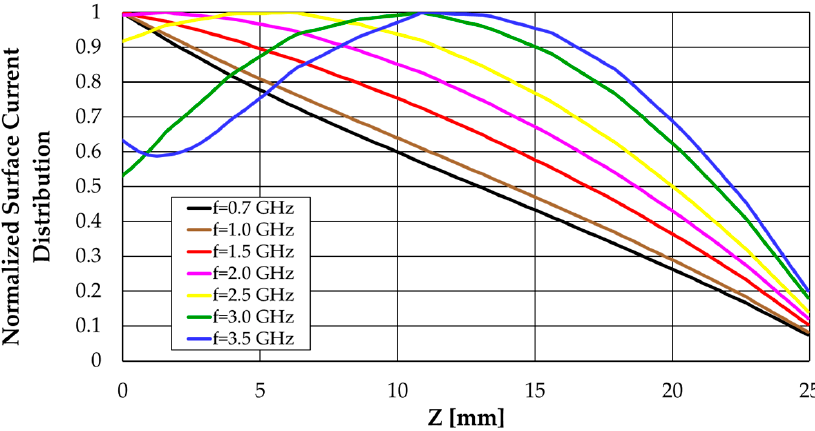
Figure 6. CST simulated vertical surface current distribution along the straight monopole.